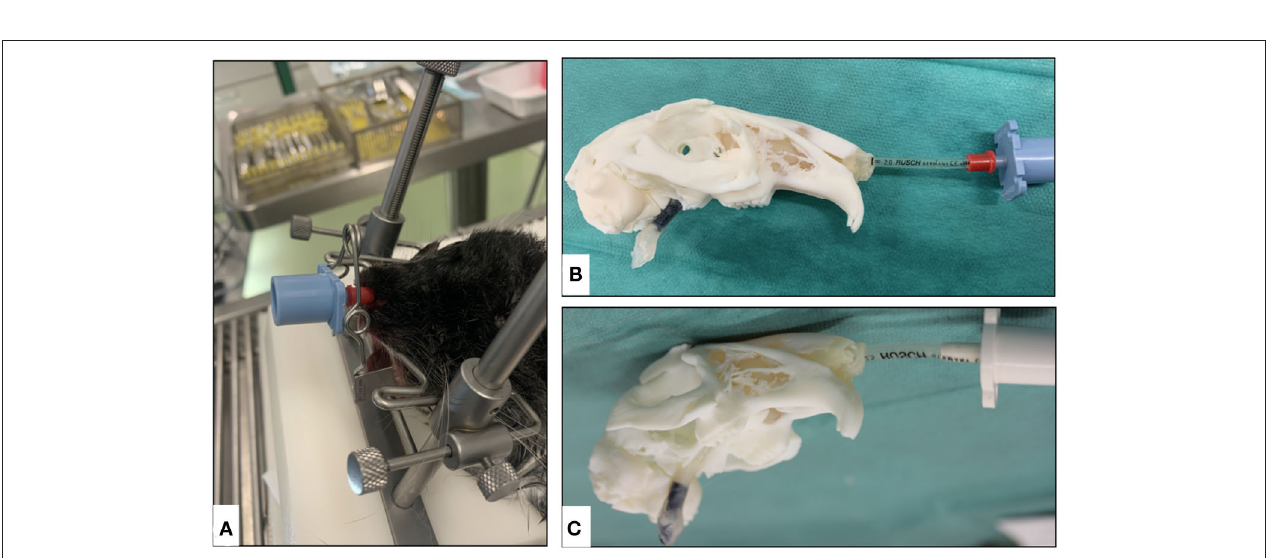
FIGURE 11 | Overview of the nasotracheal intubation in animal specimen and additively manufactured models. (A) Animal specimen intubation using a 2-mm tube, (B) model 1 intubation using a 2-mm tube, and (C) model 1 intubation using a 2.5-mm